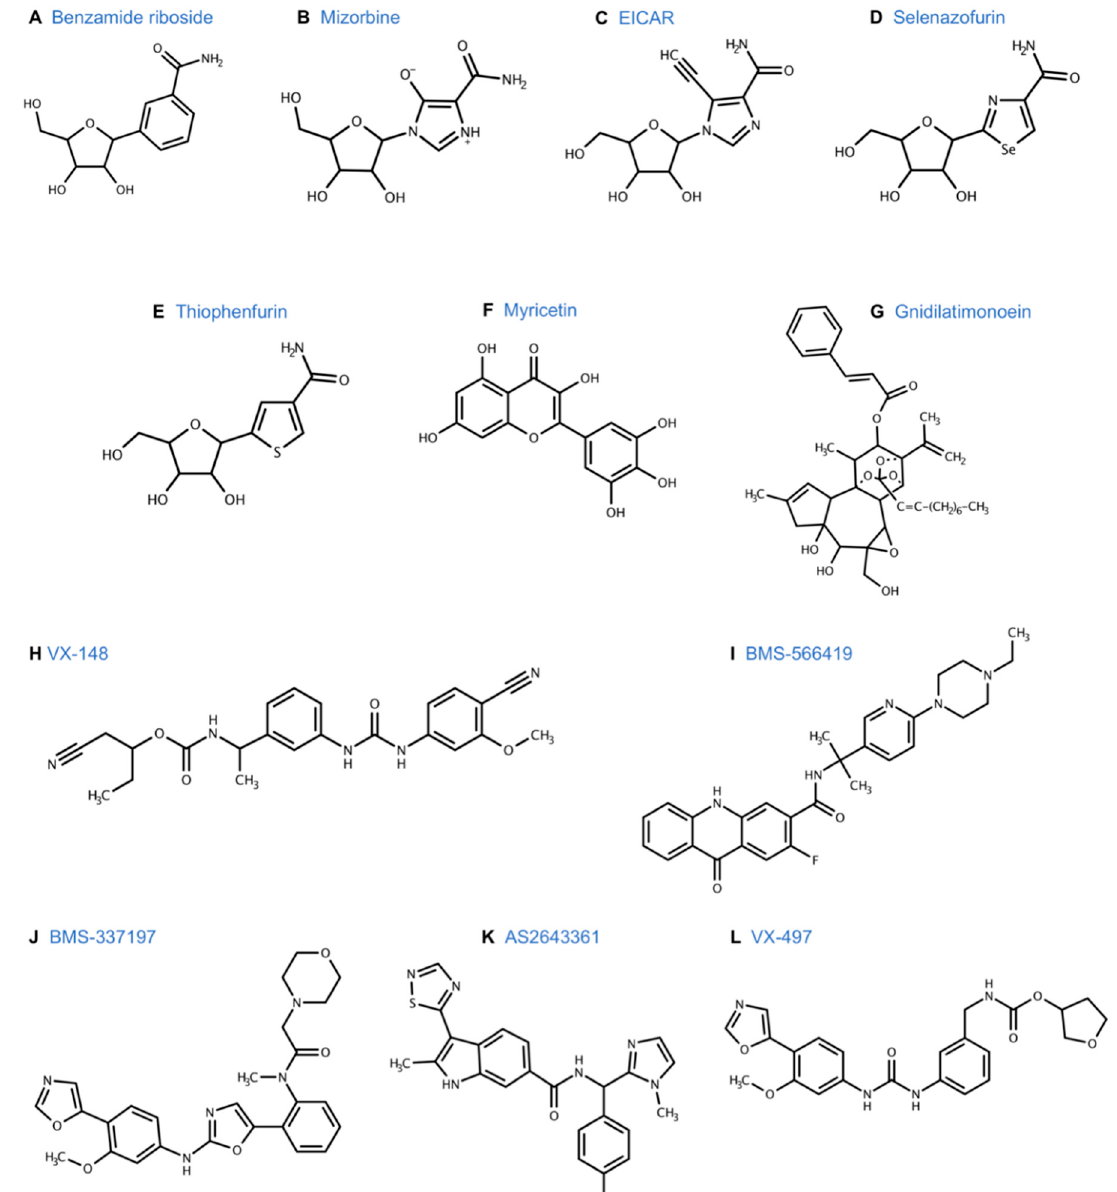
Figure 7. Other IMPDH inhibitors of chemical structures.